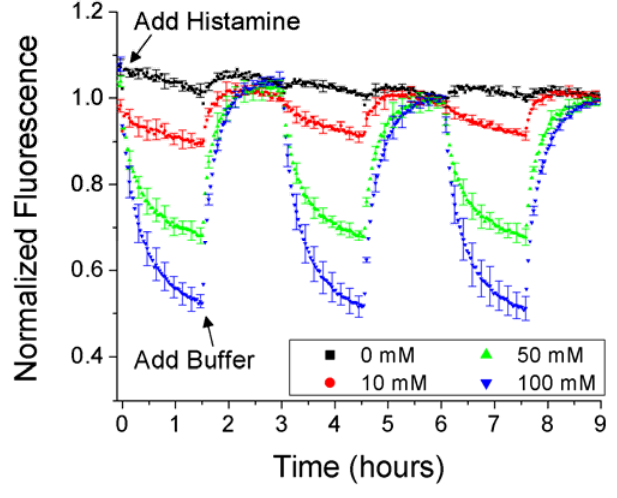
Figure 1. Bulk optodes utilizing nonactin as an ionophore are able to reversibly detect histamine in aqueous solutions. Note: to clarify image, only one of every five error bars is shown here. Please see Supplementary Information for the full